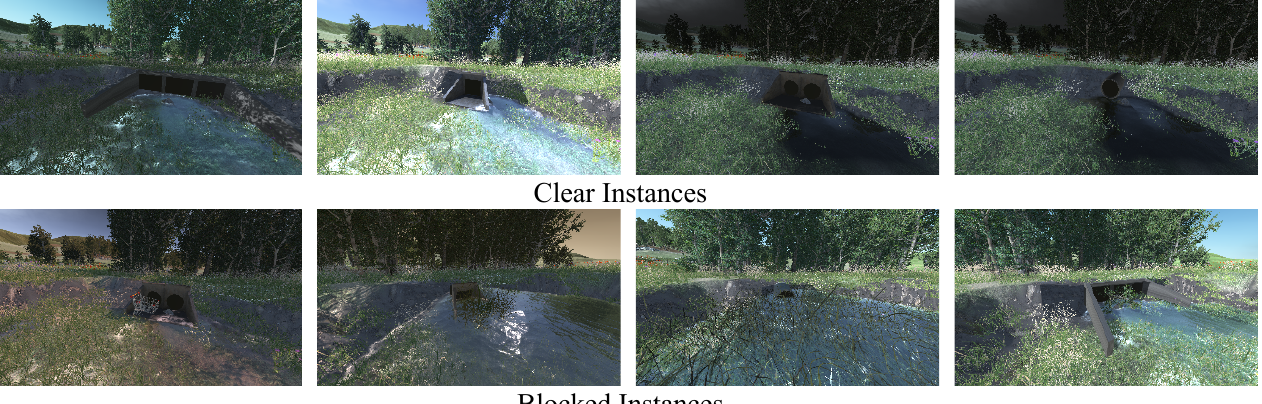
Figure 3. Sample instances of clear (First row) and blocked (Second row) culverts from